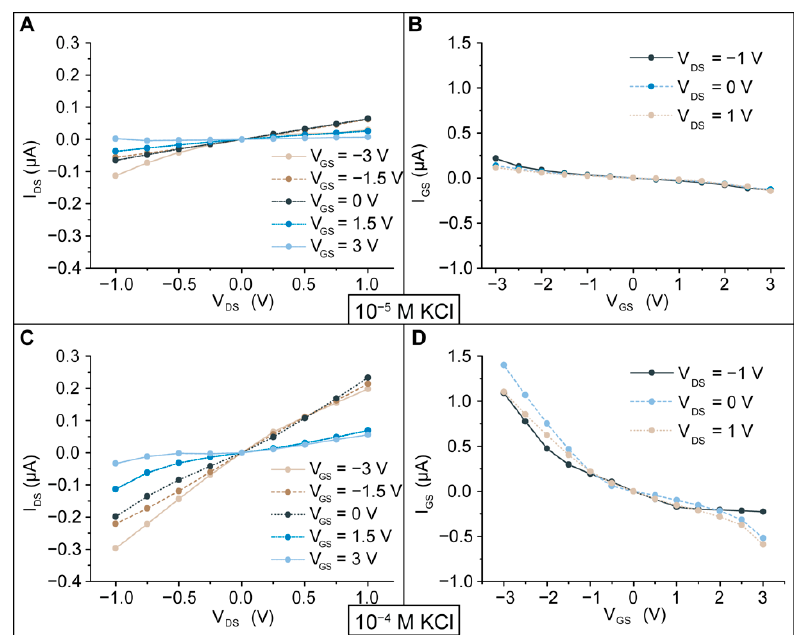
Figure 6. I-V (I DS vs. V DS ) ionic transfer characteristics and leakage current (I GS vs. V GS ) characteristics of the nanofluidic membrane measured for 10 − 5 M KCl ( 𝜆~96 nm ) and 10 − 4 M KCl ( 𝜆~30 nm) . ( A ) I DS vs. V DS measured for 10 − 5 M KCl. ( B ) I GS vs. V GS measured for 10 − 5 M KCl. ( C ) I DS vs. V DS measured for 10 − 4 M KCl. ( D ) I GS vs. V GS measured for 10 − 4 M KCl.